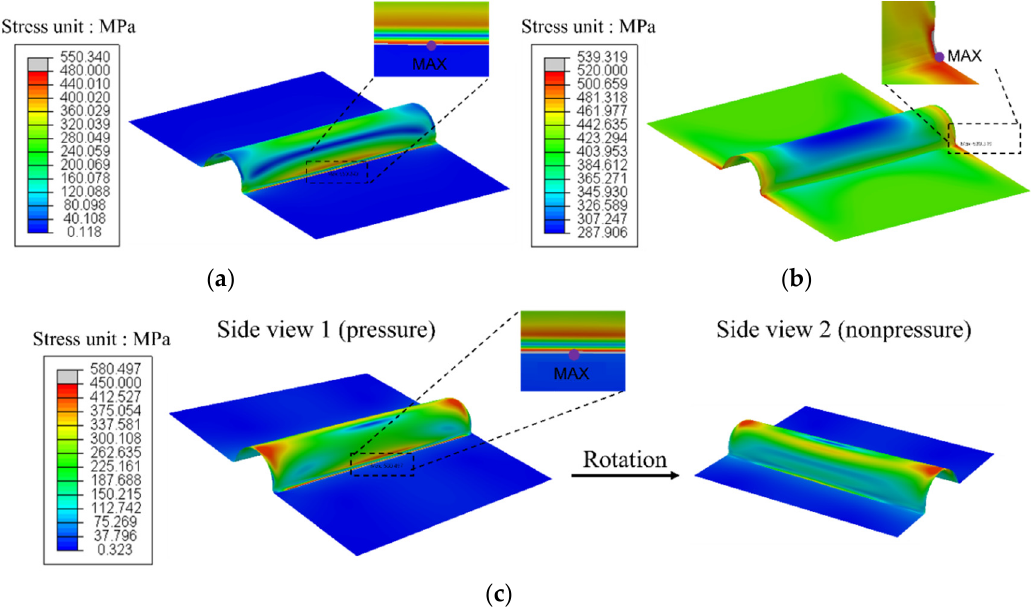
Figure 8. Stress distribution for case No. 32 in ( a ) symmetric pressure analysis, ( b ) thermal shrinkage analysis, and ( c ) asymmetric pressure analysis. The black dashed rectangle and purple dot represent the points under maximum stress. Side view 1 (pressure) represents the pressure side, and side view 2 (nonpressure) represents the opposite case.